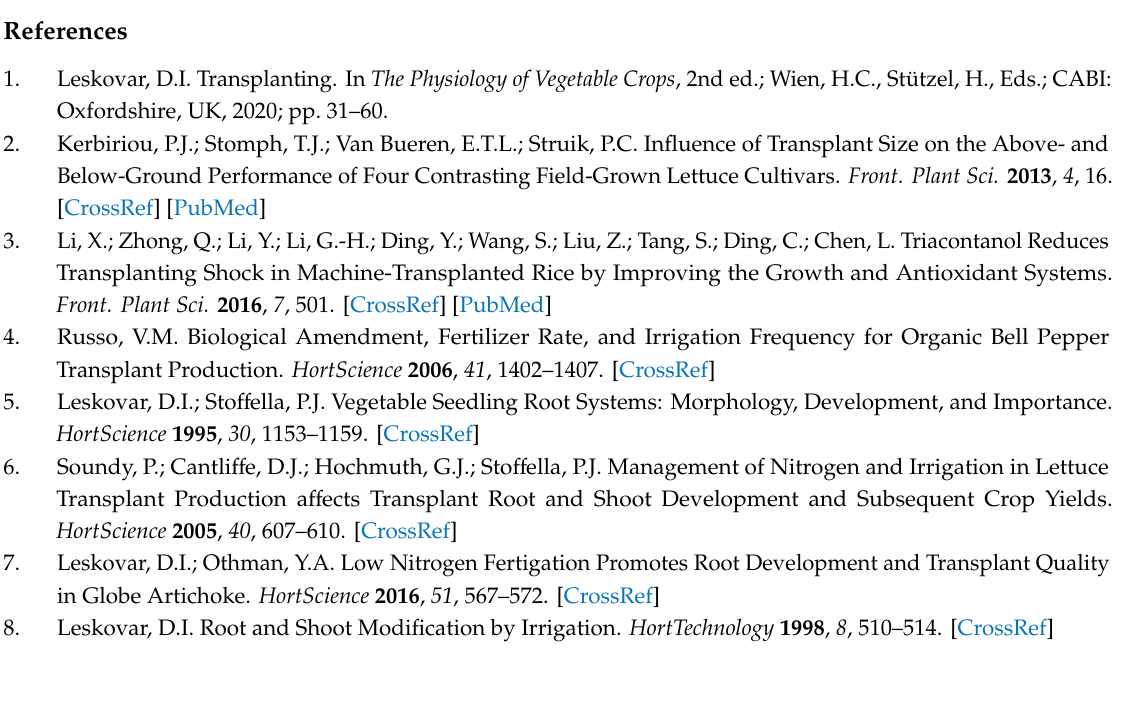
Figure S1: Vegetable crops and cultivars used in this study, Table S1: Abbreviations and their full names used in this study, Table S2: ANOVA and means comparison of germination percentage as a ff ected by amendments (A), Table S3: Summary of HS e ff ects on transplant quality traits (pre- and post-transplanting) and yield components (cool vs. hot seasons, low vs. high irrigation rates) compared to control (higher or lower at significant level P ≤